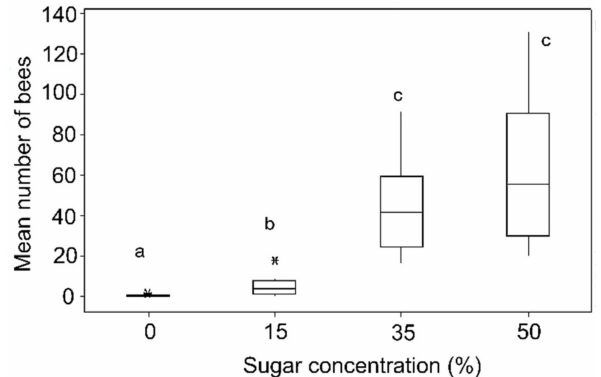
Figure 3. Mean number of Heterotrigona itama that visited the four different sucrose concentrations: 0%, 15%, 35%, and 50%. The box demonstrates the interquartile range (IQR), the horizontal line in the box represents the median value of the data. The Whiskers extend represent the maximum and minimum value of the data, excluding outliers. Note that the same letter indicates no significant difference (Kruskal–Wallis test followed by all of the pairwise multiple comparisons, p > 0.05, N = 10 trials for all of the variables).